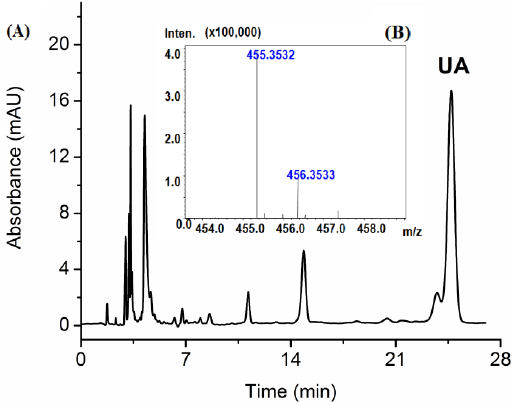
Figure 5. The high performance liquid chromatography (HPLC) chromatograms of the Hedyotis diffusa extract obtained using subcritical water extraction ( A ) and mass spectra of ursolic acid ( B ).